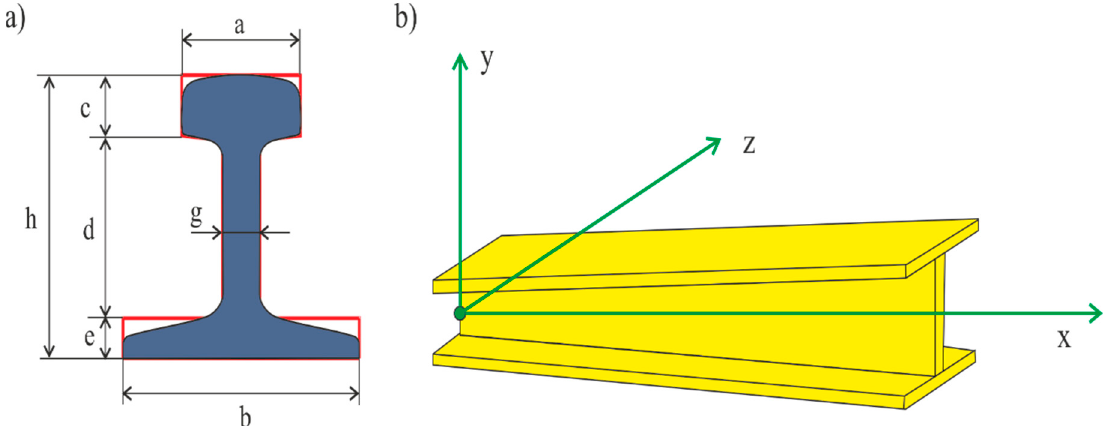
Figure 4. Parameters of the beam cross-section and position of the beam in the global coordinate system, ( a ) forward view, ( b ) side view.